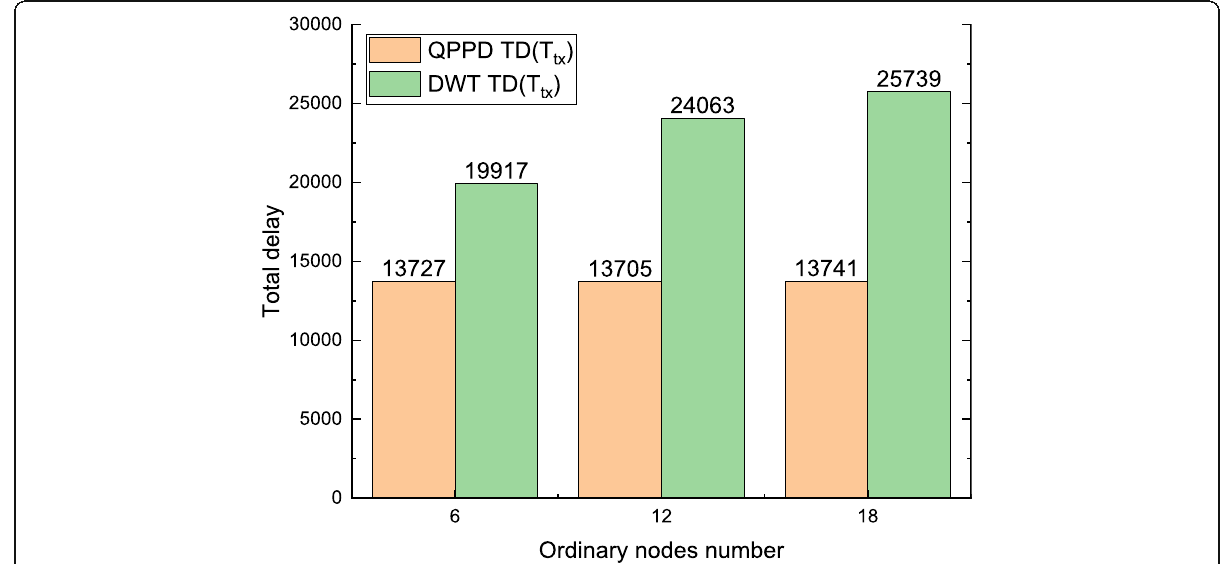
Fig. 30 The total volume of data is equal to 6 in each cycle; the total